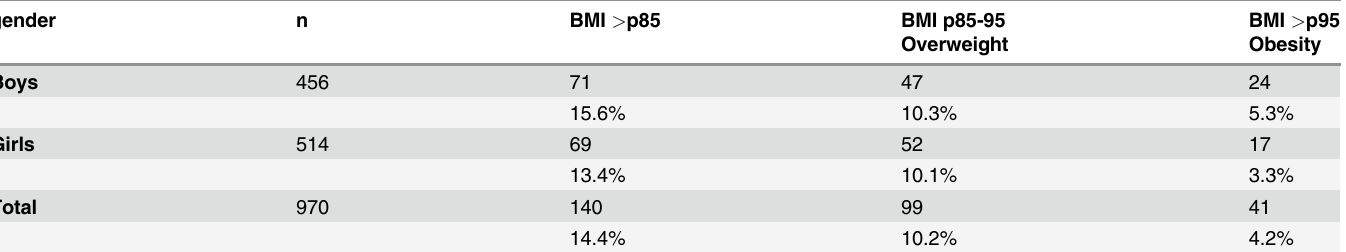
Table 4. The prevalence of overweight and obesity in Cracovian boys and girls aged 14 – 18 based on Polish children growth reference 2010 (OLAF study) [14].